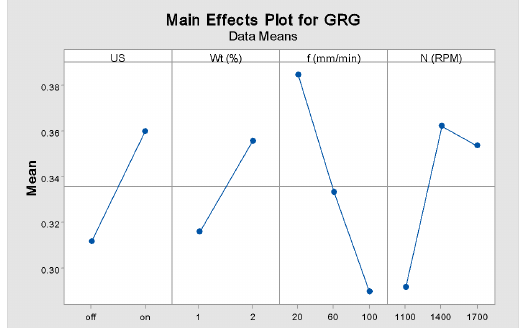
Figure 21. Interactive effect of process parameters on grey relational grade.